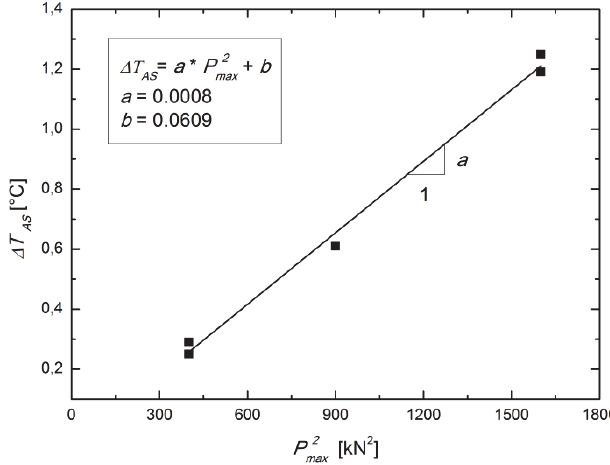
Figure 16: Linear regression values Δ T AS in function of P 2 max.